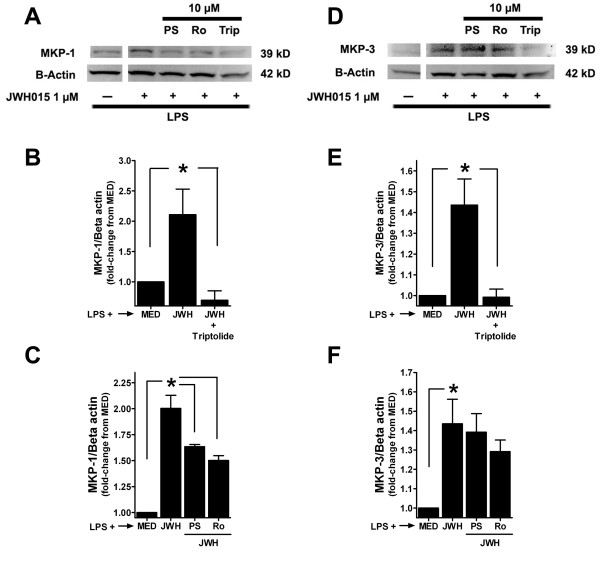
Blockade of JWH015's effects on MKP-1 and MKP-3. (A) Representative western blots of MKP-1 and beta-actin in primary microglia treated with LPS in the absence or presence of JWH015 (15 min incubation, JWH). Cells were pre-incubated with or without 10 μM PSI2106 (PS), Ro-31-8220 (Ro) or triptolide (Trip) for 30 min. (B) Triptolide (10 μM) completely blocked the MKP-1 expression induced by JWH015 (1 μM). (C) PSI2106 or Ro-31-8220 partially inhibited the MKP-1 expression induced by JWH015. (D) Representative western blots of MKP-3 and beta-actin in primary microglia treated with LPS in the absence of presence of JWH015 (15 min incubation). Cells were pre-incubated with or without PSI2106, Ro-31-8220 or triptolide (10 μM) for 30 min. (E) Triptolide (10 μM) completely blocked the MKP-3 expression induced by JWH015 (1 μM). (F) PSI2106 or Ro-31-8220 did not modify the MKP-3 expression induced by JWH015. *p < 0.05 vs. LPS + medium (MED) or LPS + JWH015 + PSI2106, Ro-31-8220 or triptolide group (indicated by the connecting lines).